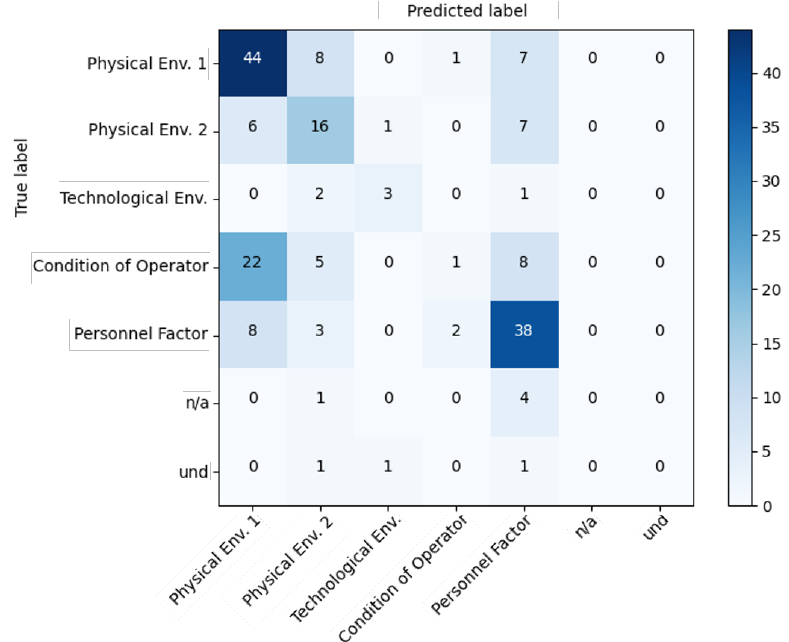
Figure 6. Precondition for Unsafe Act confusion matrix, with down-sampled “Physical Env. 1”.